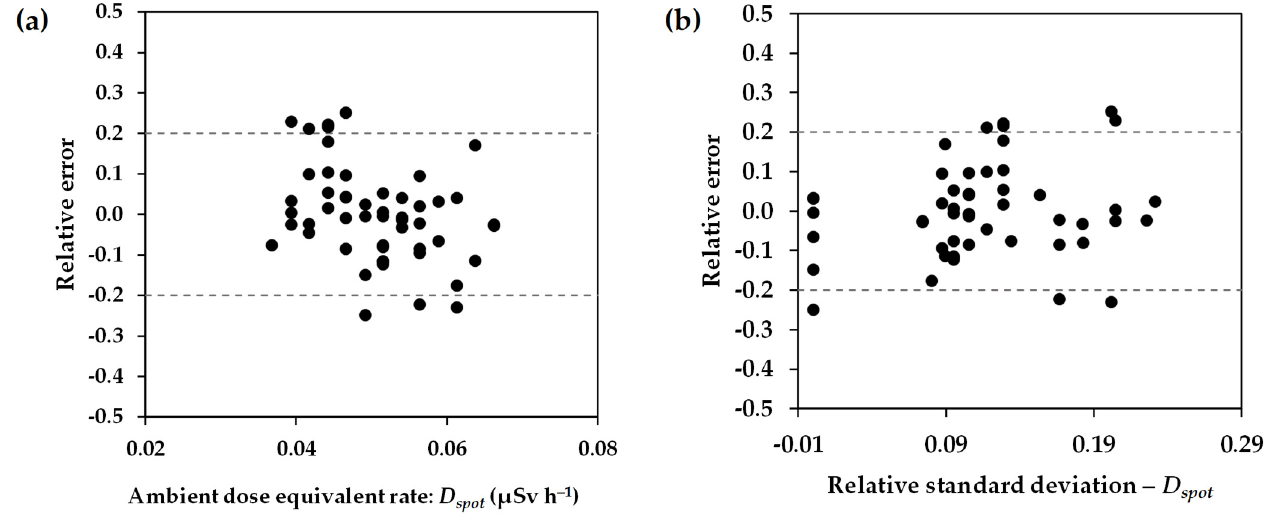
Figure 10. Scatter plots of ( a ) relative error in walking survey measurements against ambient dose equivalent rates of spot measurements and ( b ) relative error in walking survey measurements against relative standard deviation of spot